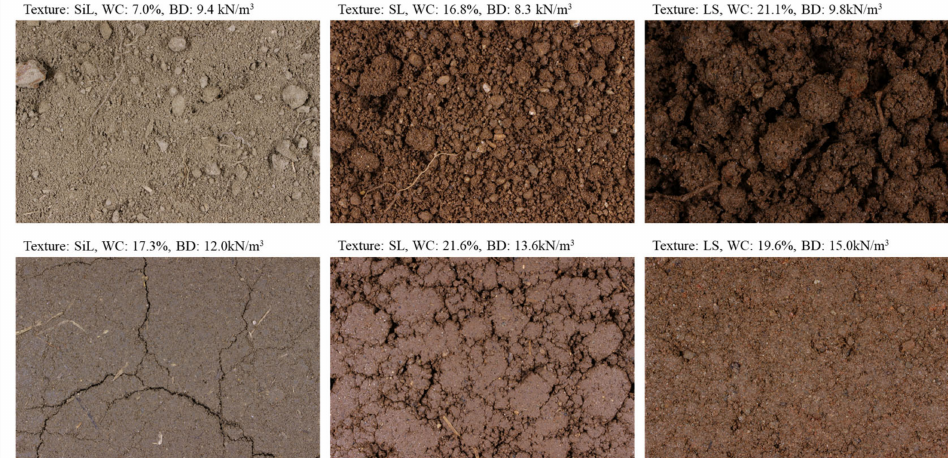
Figure 2. Sample soil surface images acquired from sampling point A, B and